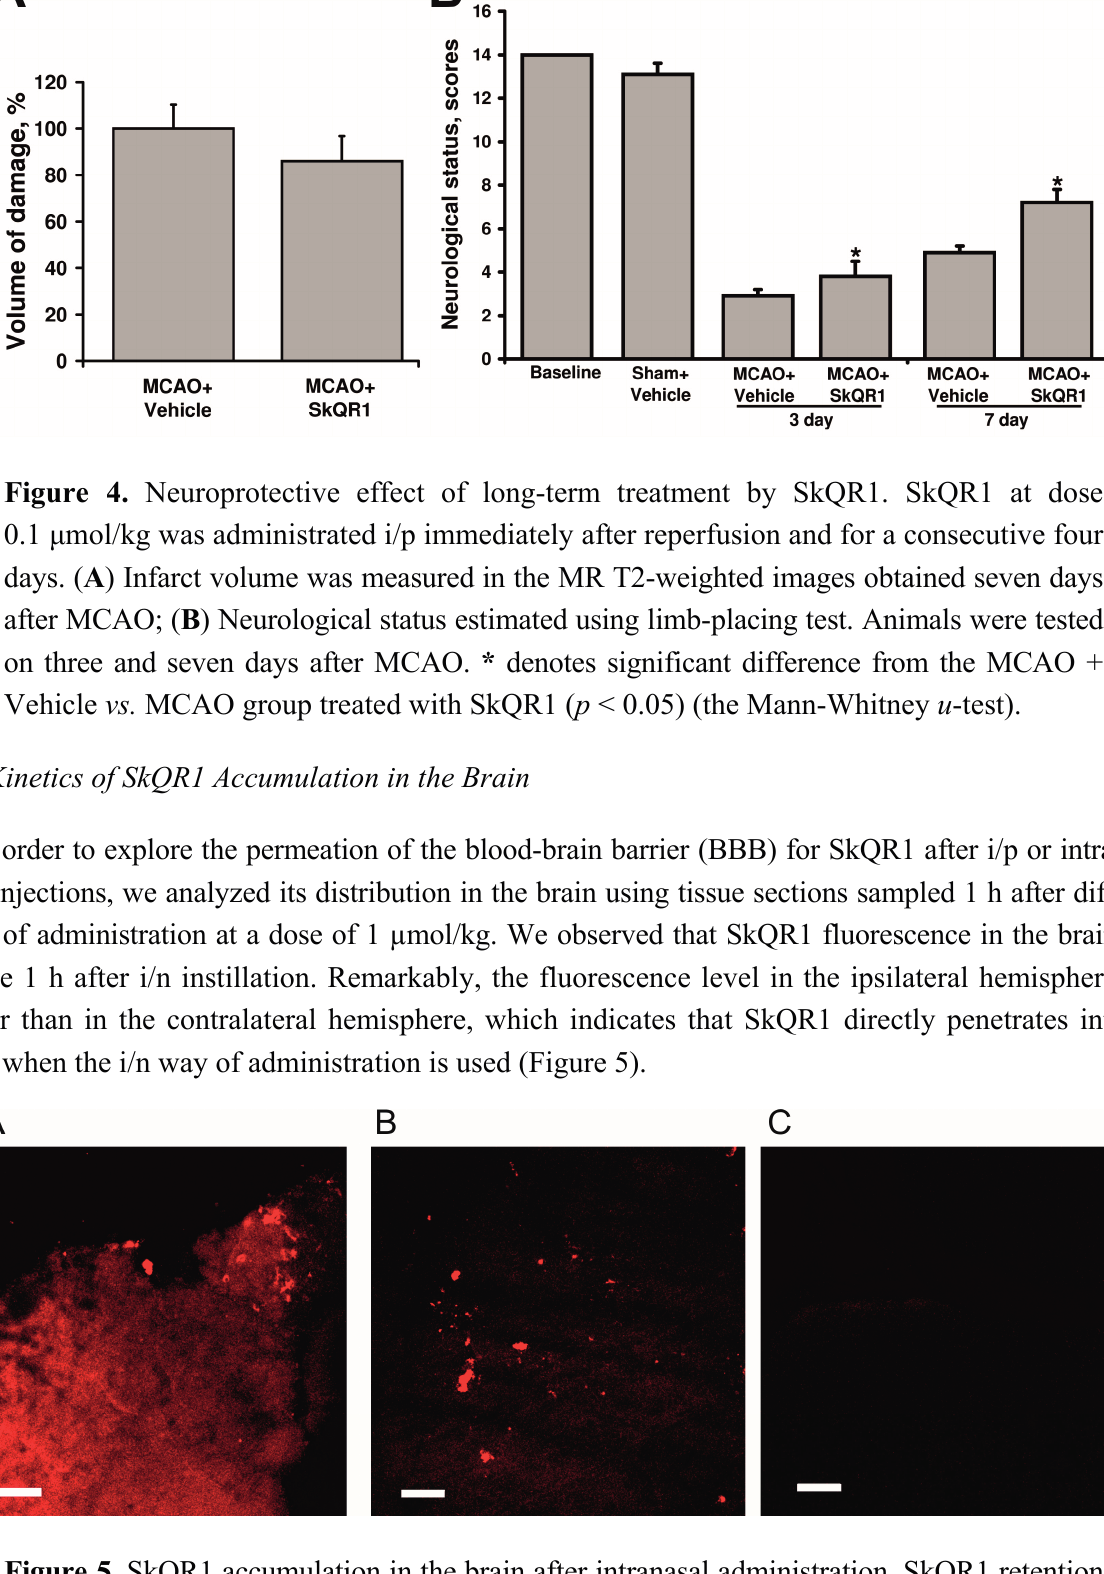
Figure 5. SkQR1 accumulation in the brain after intranasal administration. SkQR1 retention and distribution over brain compartments 1 h after i/n instillation of 1 µmol/kg SkQR1. Confocal microscopy of tissues slices. ( A ) The ipsilateral hemisphere and ( B ) the contralateral hemisphere; ( C ) As a negative control, brains from untreated animals were analyzed. Bar, 50